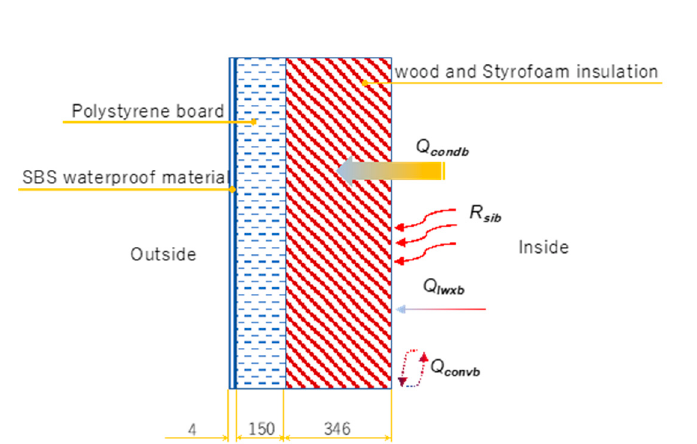
Figure 8. Heat transfers in the greenhouse back roof (unit, mm).